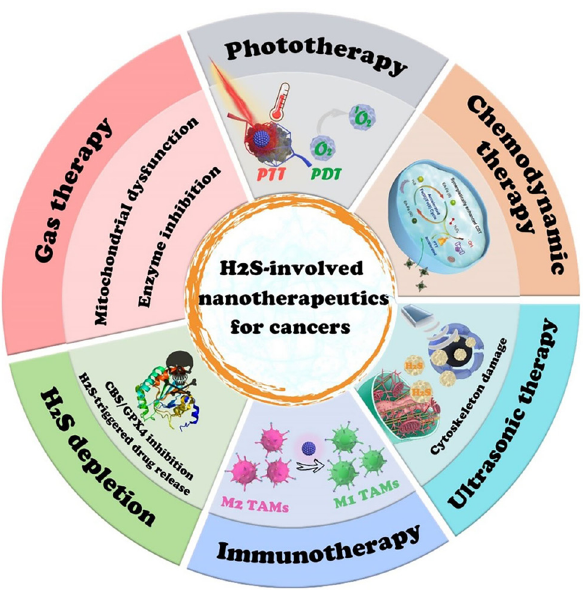
Figure 1: Schematic illustration showing the classi fi cation of H 2 S - involved nanotherapeutics for